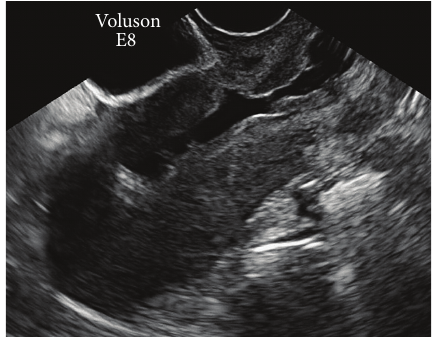
Figure 3: Nineteen months after the caesarean section. Saline infusion sonohysterography shows that despite the presence of a 4 mm defect “isthmocele,” myometrium continuity was